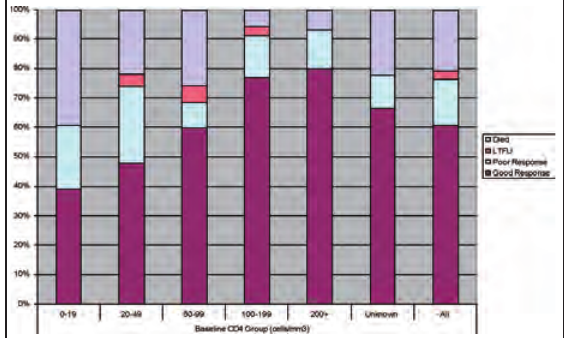
Fig. 1. Breakdown of known patient outcomes by baseline CD4 group in 145